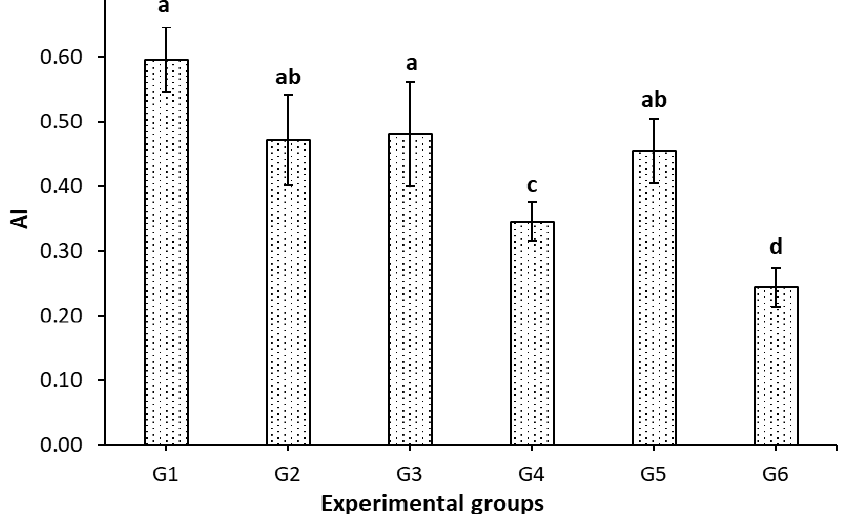
Figure 1. Effect of IF, FCM, and FCM-D on the atherogenic index in obese rats fed a high-fat diet for 6 weeks, n = 8. G1 – G6: experimental groups see materials and methods, Section 2.3; a,b,c : bars not sharing similar letters are significantly different ( p > 0.05).